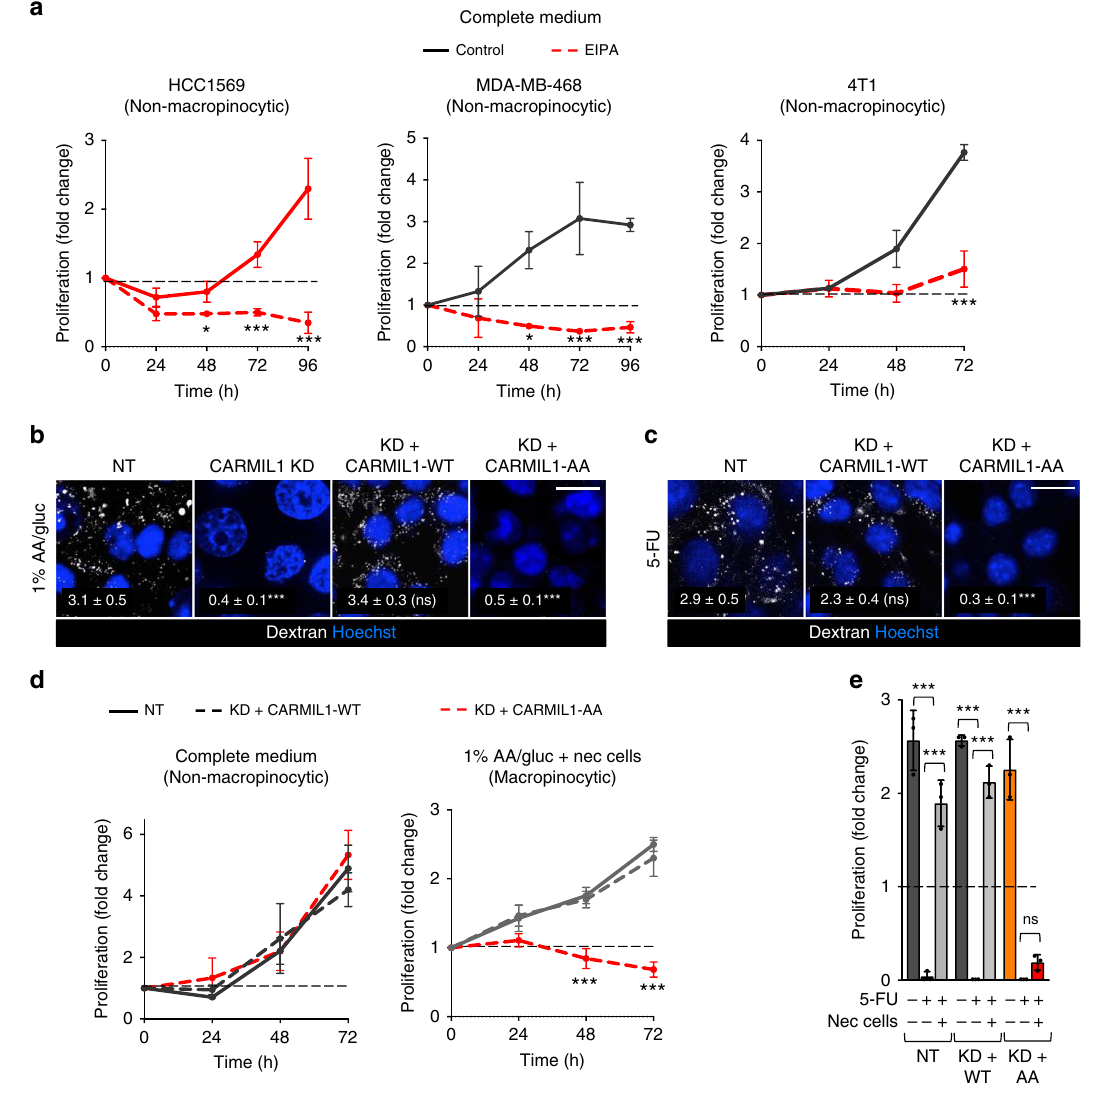
Fig. 6 CARMIL1-AA supports proliferation, but not macropinocytosis, in mammary cancer cells. a Breast cancer cell line proliferation in complete medium ± EIPA (25 μ M (HCC1569 and MDA-MB-468) or 10 μ M (4T1, 4T1 cells are hypersensitive to EIPA)). Mean ± SD shown, n = 3. Using an unpaired, two-tailed t-test at each time point, * P ≤ 0.05; *** P ≤ 0.001; no asterisk, P > 0.05. b Dextran uptake in 4T1 cells expressing a non-targeting shRNA (NT) or a CARMIL1-shRNA in 1% AA/glucose. Where indicated, CARMIL1 knockdown cells were reconstituted with shRNA-resistant CARMIL1-WT or CARMIL1-AA cDNAs. c As in b , but in complete medium 1 h after treatment with 5-FU (5 μ M). For b and c , dextran index in white (mean ± SEM); 30 cells from two independent experiments were evaluated. Using a one-way ANOVA with Dunnett ’ s correction, *** P ≤ 0.001; ns, not signi fi cant, P > 0.05. Scale bars, 20 µ m. d Proliferation of 4T1 cells in complete medium or 1% AA/gluc with necrotic cells (0.2% protein). Mean± SD shown, n = 3. Using a one-way ANOVA at each time point and Dunnett ’ s correction, *** P ≤ 0.001; no asterisk, P > 0.05. e As in d , but cells in complete medium were treated with 5-FU (1 μ M) ± necrotic debris (0.2% protein) and proliferation measured at 72 h. Mean± SD shown, n = 3. Using a one-way ANOVA and Tukey ’ s